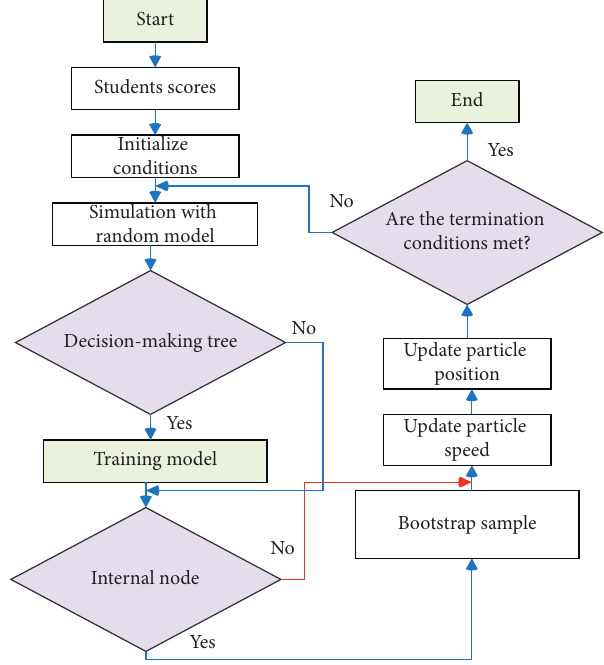
Figure 4: Principles of random forest